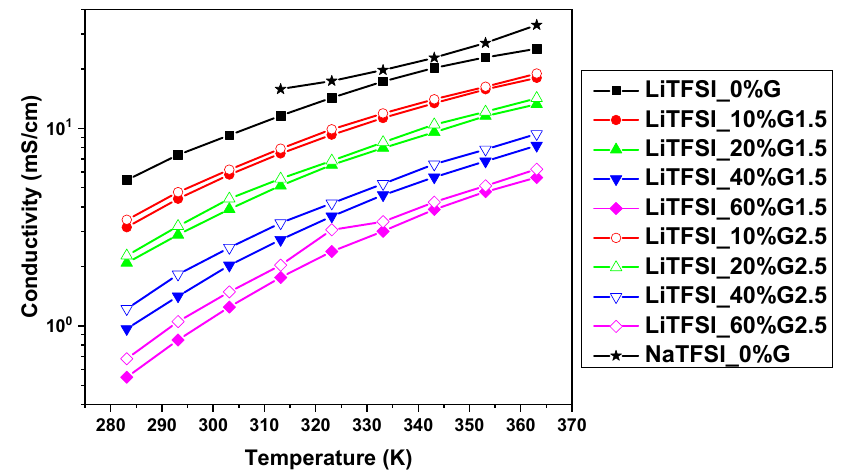
Figure 7. Temperature dependence of ion conductivities calculated from PFG NMR self ‐ diffusion coefficients for NaTFSI_0%G electrolyte and LiTFSI electrolytes with different amounts of PAMAM. The solid lines are guides for the eye.